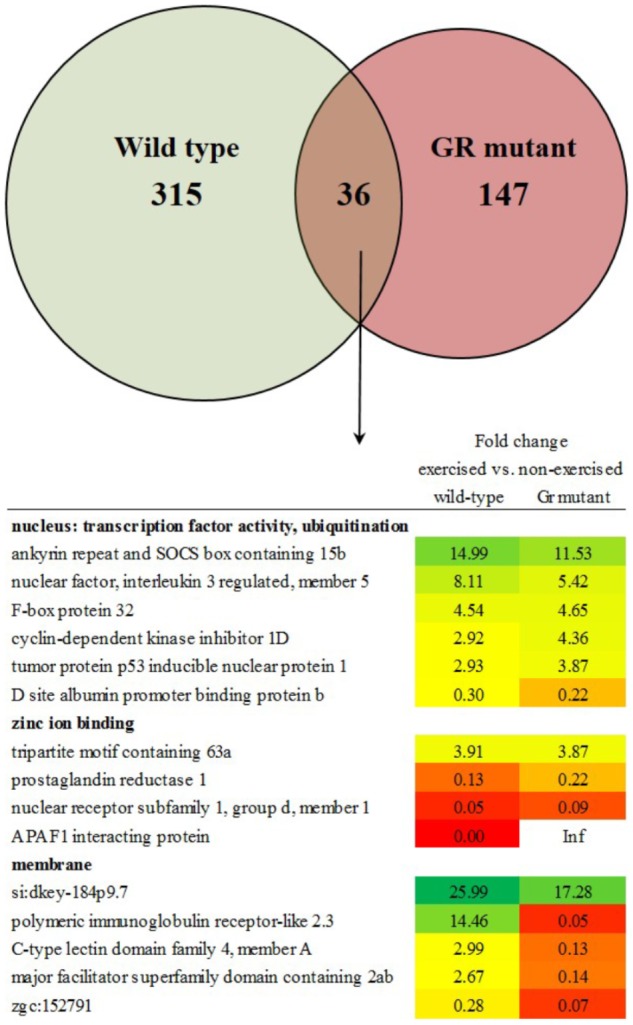
Enriched functional categories of differentially expressed genes (DEGs) specific for wild-type zebrafish, for Gr mutants and the DEGs that both groups had in common. Also shown is the functional annotation clustering of the commonly expressed genes.